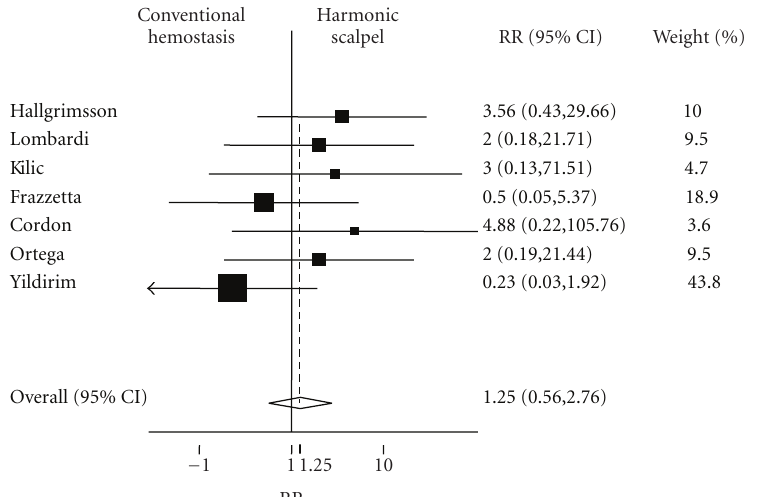
Figure 4: Forest plot depicting individual and pooled risk ratios (RRs) with 95% confidence intervals (CIs) for transient postoperative recurrent laryngeal nerve dysfunction.